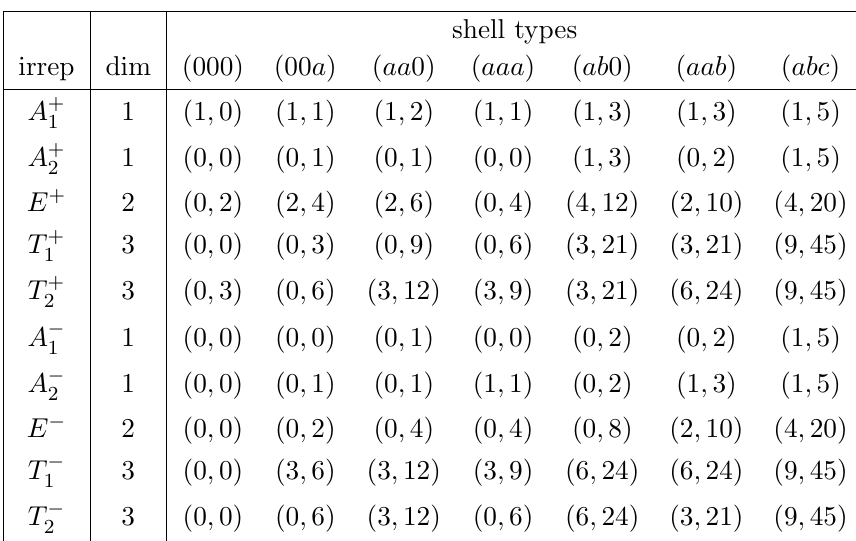
Table 1. Dimension of irrep projection sub-blocks for each shell-type and angular momentum, ( d ( P I;o ; d ( P I;o )). Each row corresponds to an irrep of the cubic group O h , whose dimension (0)) (2) is also listed for completeness.